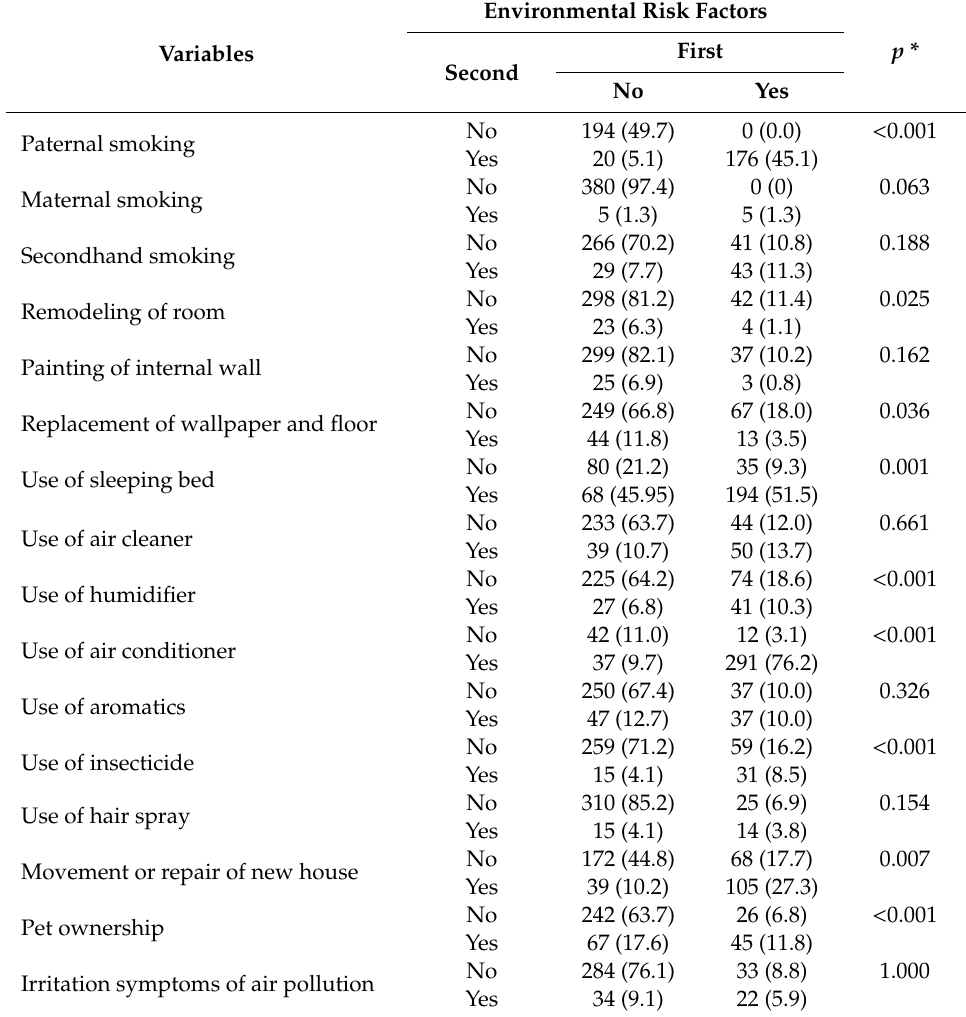
Table 4. Comparison of changes in the individual risk of environmental factors between the first and second survey (categorical